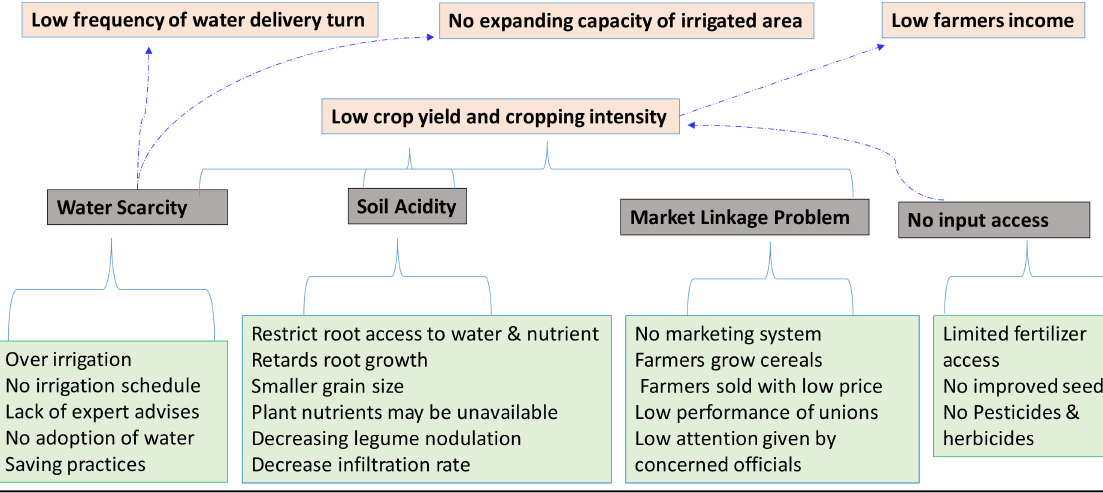
Figure 7. A conceptual framework showing that water shortage affects the frequency of water delivery turn, and the expansion capacity of the irrigated area. The interaction of these constraints affects crop yield and farmer’s income. Modified from Ghazouani et al.